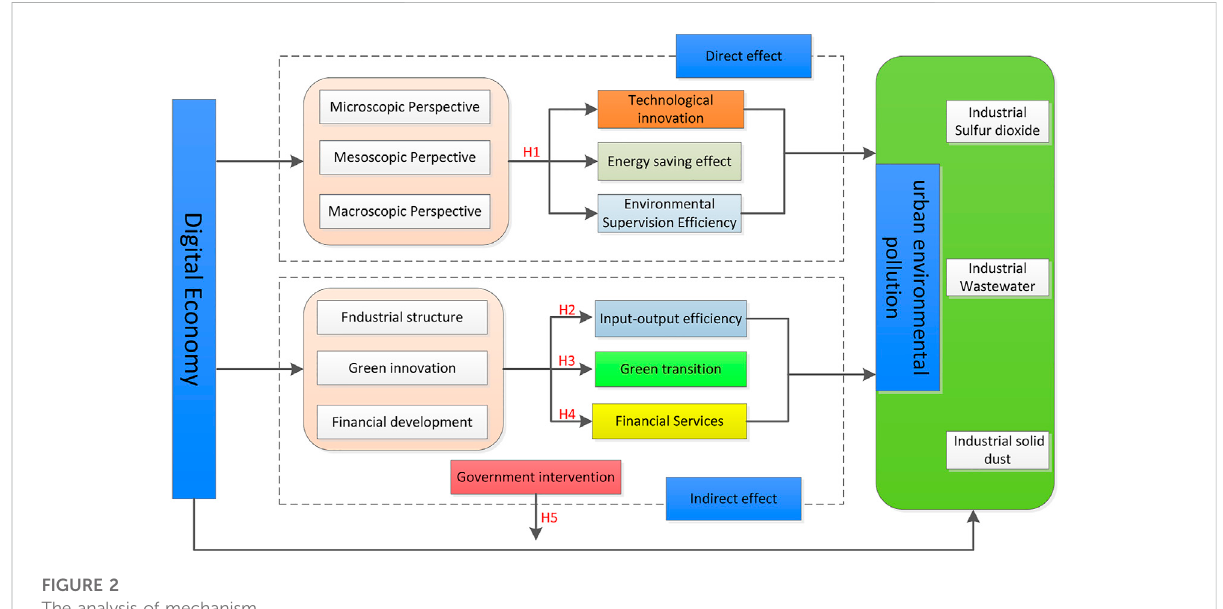
FIGURE 2 The analysis of mechanism.